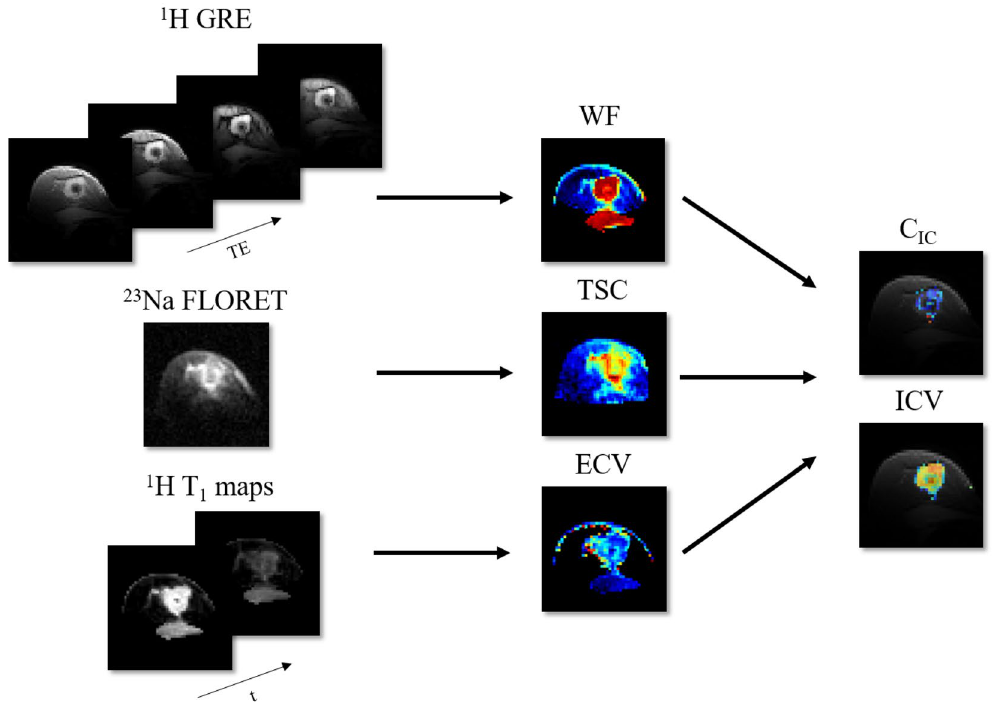
Figure 2. Quantification pipeline: a combination of 23 Na and 1 H imaging modalities are employed to isolate the intracellular component of the total sodium signal. From left to right: four GRE images with incremental TE’s, a 23 Na FLORET image and two 1 H T 1 measurements (pre and post contrast) are independently elaborated to generate, respectively, WF, TSC and ECV. Ultimately, these three maps are combined (Eq. 1) to calculate C IC and